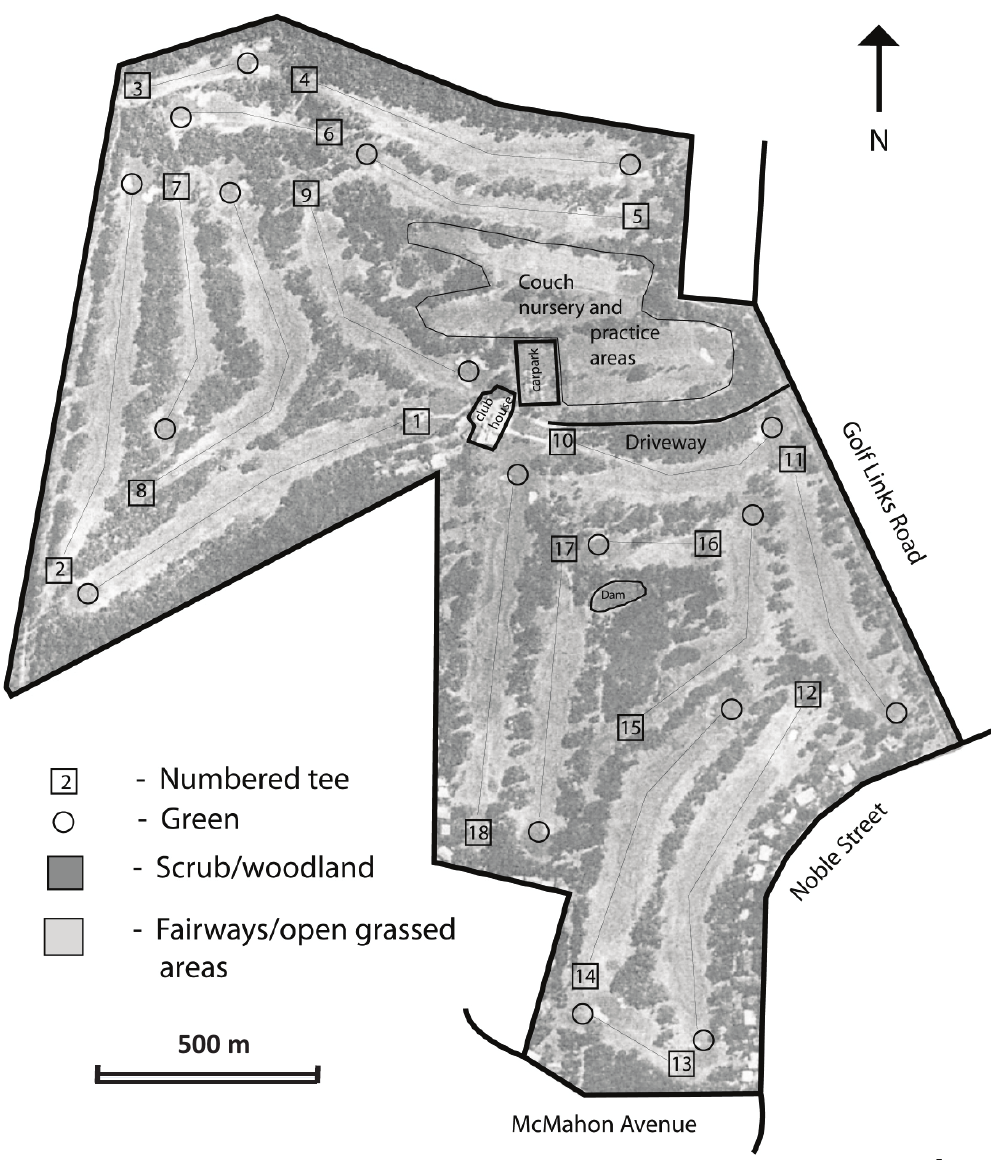
Figure 2. Aerial photograph of the Anglesea Golf Club, Victoria, Australia, showing the layout of the 18-hole course and the contrast between open foraging areas and vegetated shelter for Eastern Grey Kangaroos Macropus giganteus